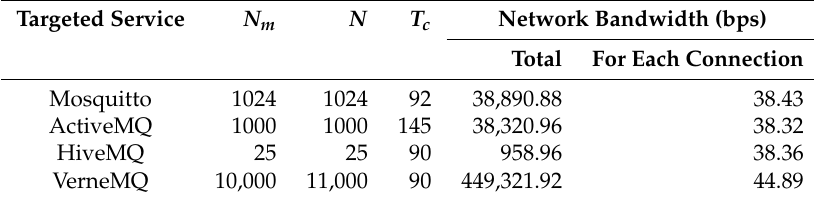
Table 1. Comparison between MQTT